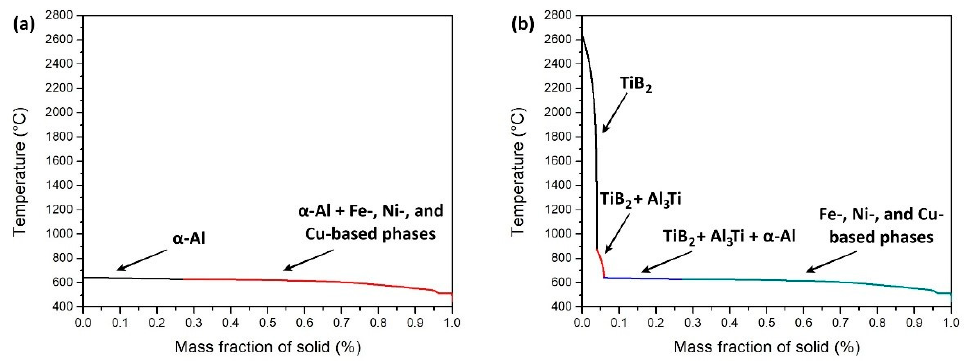
Figure 1. Solidification curves of ( a ) 2618 and ( b ) Ti/B-2618